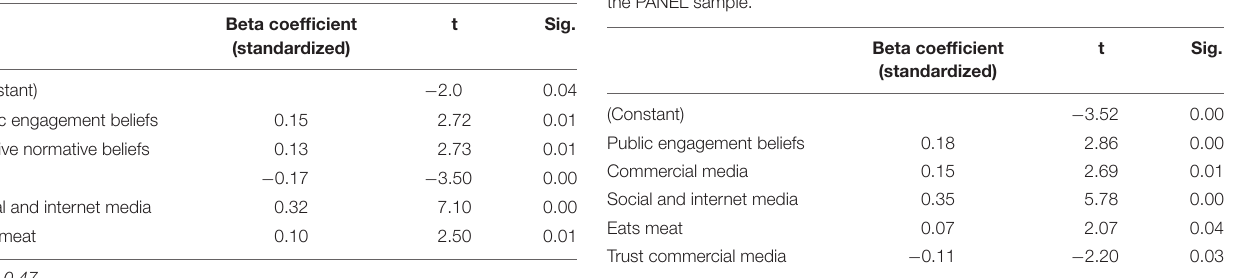
TABLE 8 | Linear regression with Community behavior as the dependent variable and all composite variables entered as the predictors, for the CATI sample.